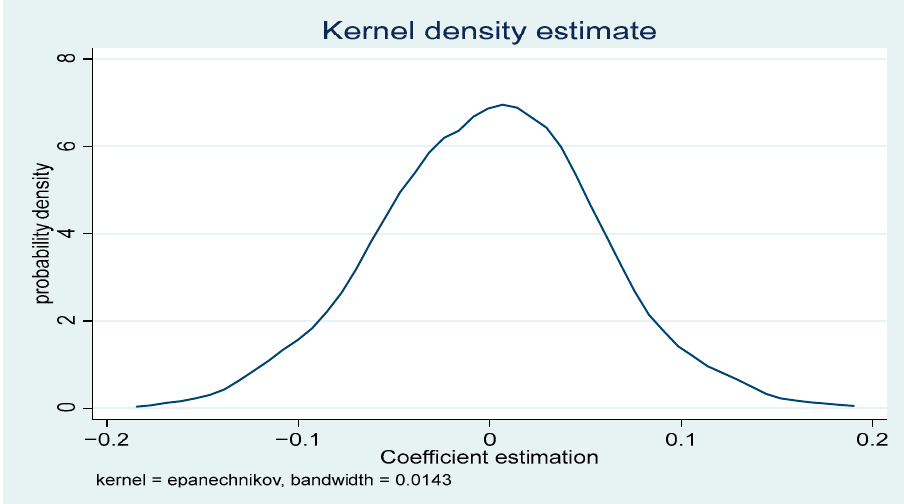
Figure 2. Placebo test.